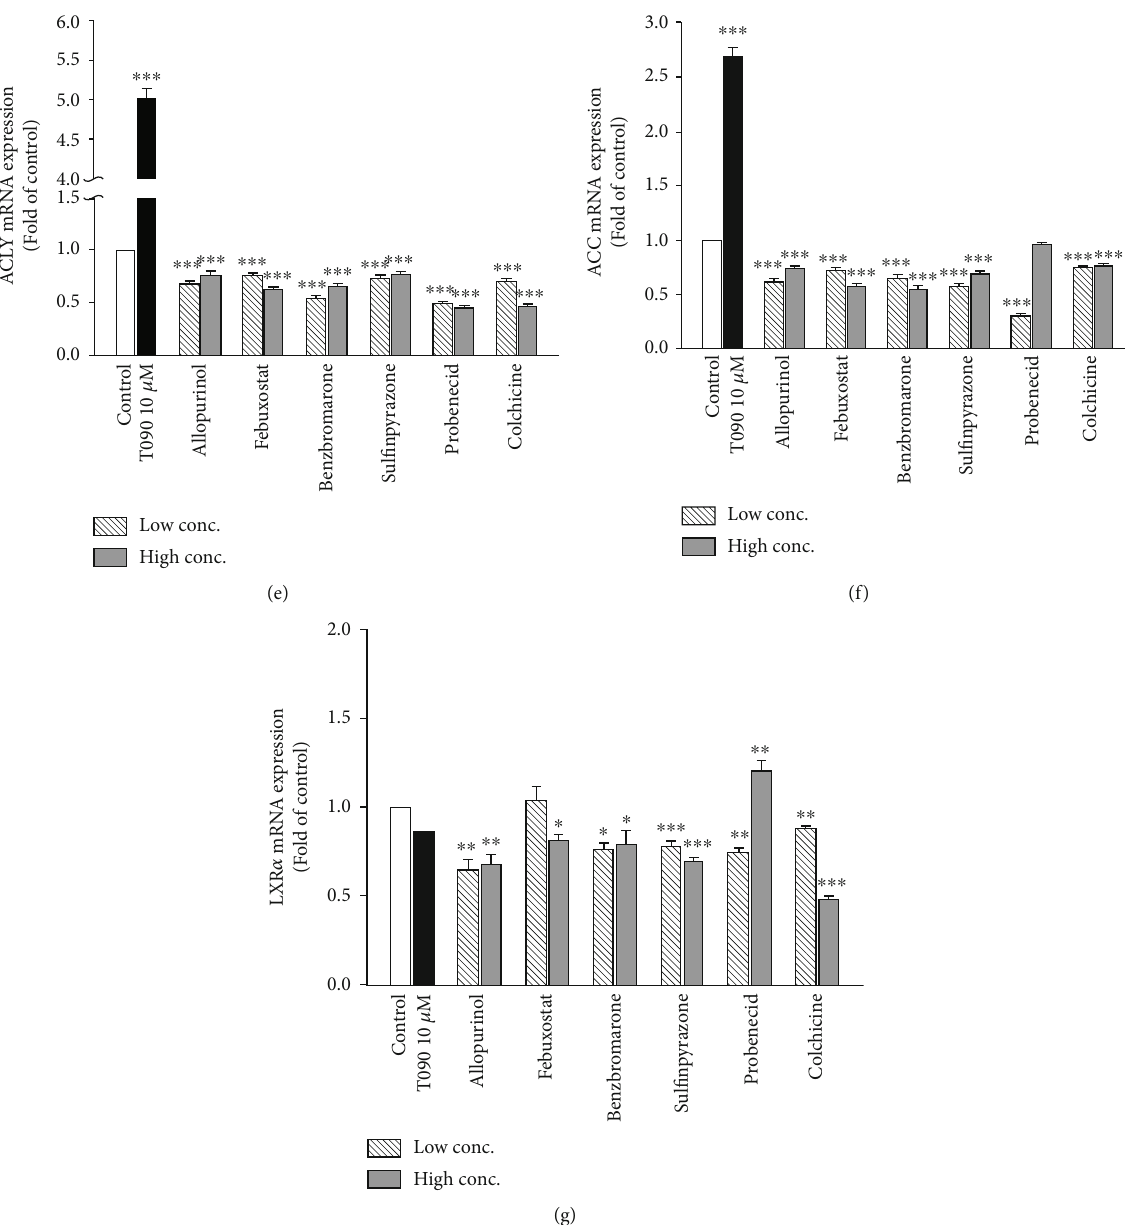
Figure 3: Expression of hepatic lipid metabolism-related genes following treatment with T0901317 and antigout drugs. Di ff erentiated HepaRG cells were treated for 24 h with T0901317 (10 μ M), allopurinol (14.7 and 22.1 μ M), febuxostat (5.66 and 13.09 μ M), benzbromarone (4.24 and 7.73 μ M), sul fi npyrazone (32.24 and 56.04 μ M), probenecid (243.9 and 520.6 μ M), and colchicine ( 7 : 51 × 10 -4 and 0.075 μ M). Following treatment, RNA was extracted, and the expression levels of (a) SREBP-1c, (b) SCD, (c) FAS, (d) FAE, (e) ACLY, (f) ACC, and (g) LXR α were analyzed by quantitative reverse transcription-polymerase chain reaction. Values were normalized to the expression of β -actin, with the β -actin levels of dimethyl sulfoxide- (DMSO-) treated cells set at 1. Results are expressed as the means ± standard error (SE) ( n = 3 ). ∗ P < 0 : 05 , ∗∗ P < 0 : 01 , and ∗∗∗ P < 0 : 001 compared with cells treated with DMSO. SREBP-1c: sterol regulatory element binding protein 1; SCD: stearoyl-CoA desaturase-1; FAS: fatty acid synthase; FAE: fatty acid elongase; ACLY: adenosine 5 ′ -triphosphate (ATP) citrate lyase; ACC: acetyl-CoA carboxylase; LXR α : liver X receptor